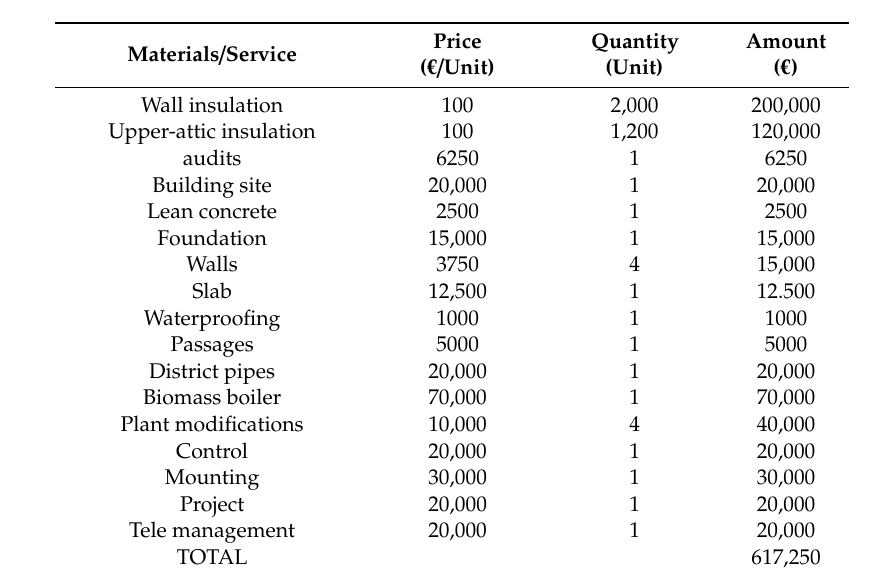
Table 11. Oulx investment